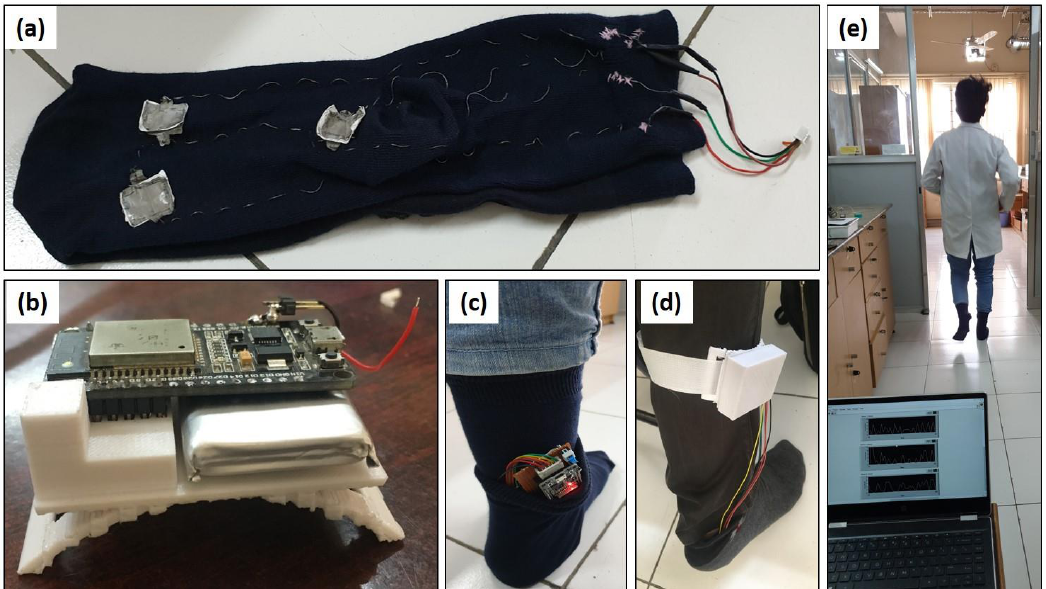
Figure 2. ( a ) The three SF-based sensors with CNF stitched in the socks by means of conducting thread; ( b ) Electronic controller unit; ( c ) Electronic controller unit connected with sensors; ( d ) Elec- tronic controller unit covered with the 3D printed case; ( e ) Sensors testing with a volunteer and LabVIEW software [Video S1: movement